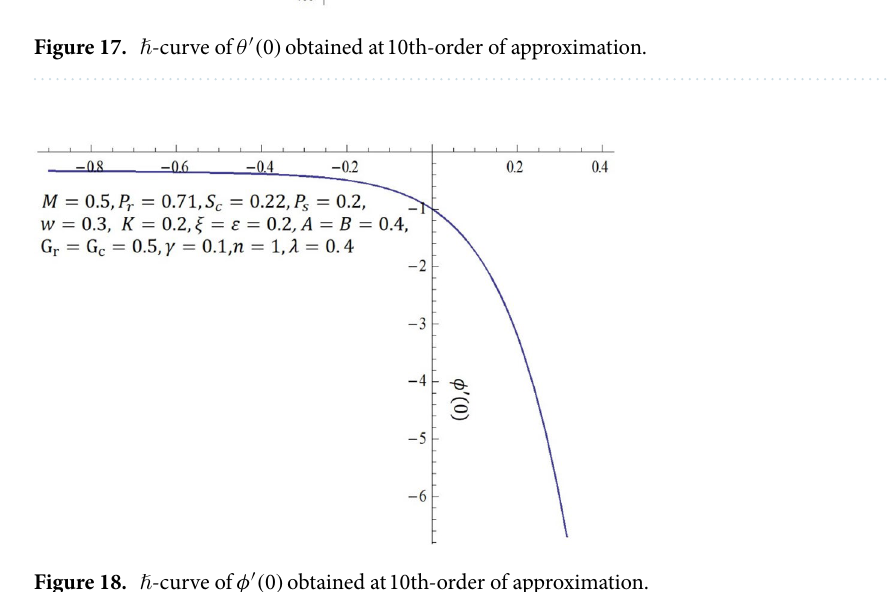
Figure 18. ℏ -curve of φ ′ ( 0 ) obtained at 10th -order of